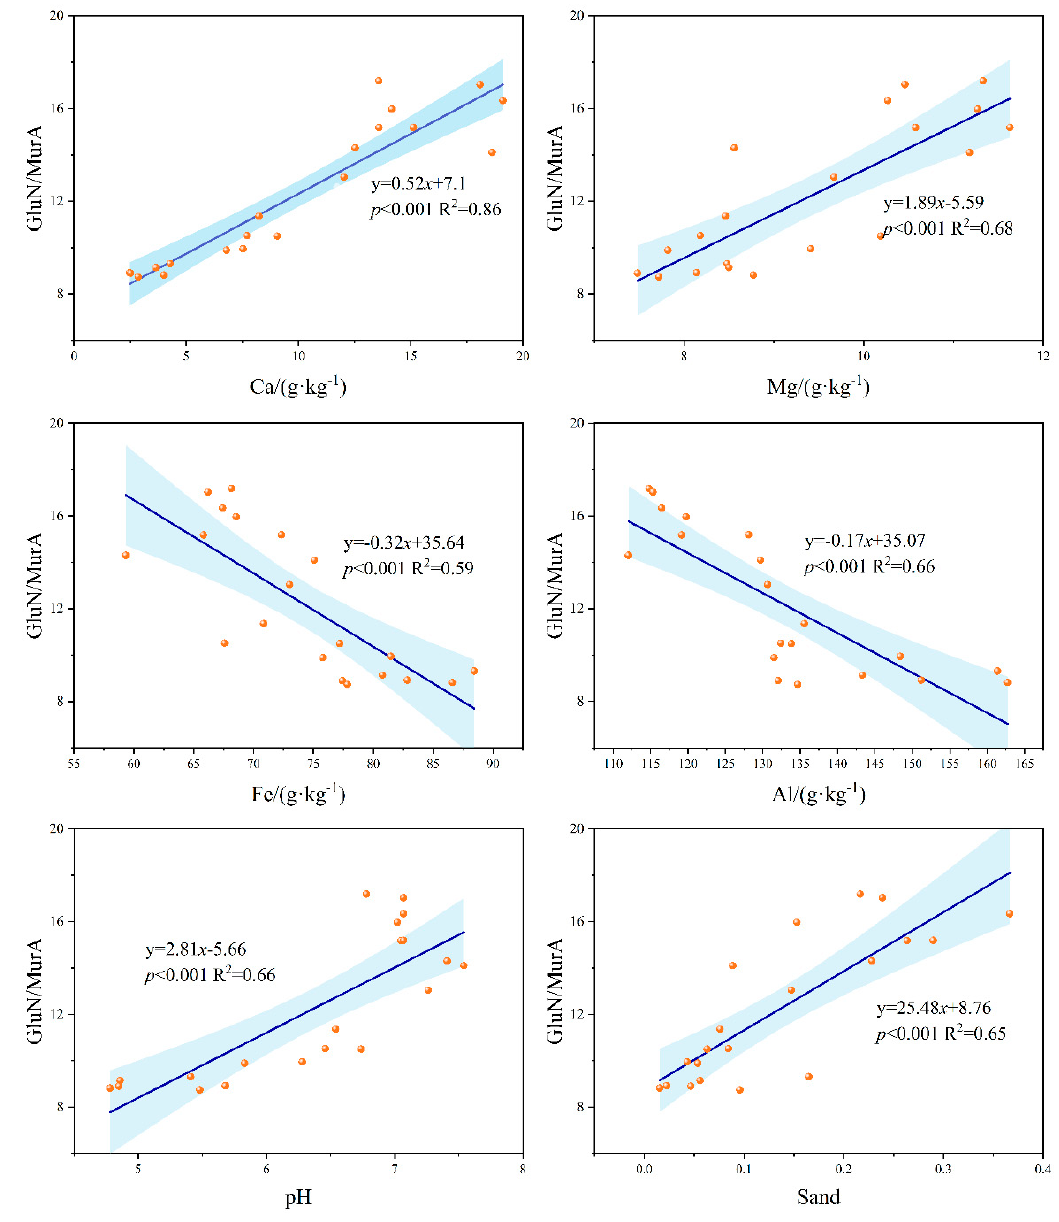
Figure 5. The relationship between soil GluN/MurA value and metallic oxides, pH value, and soil sand